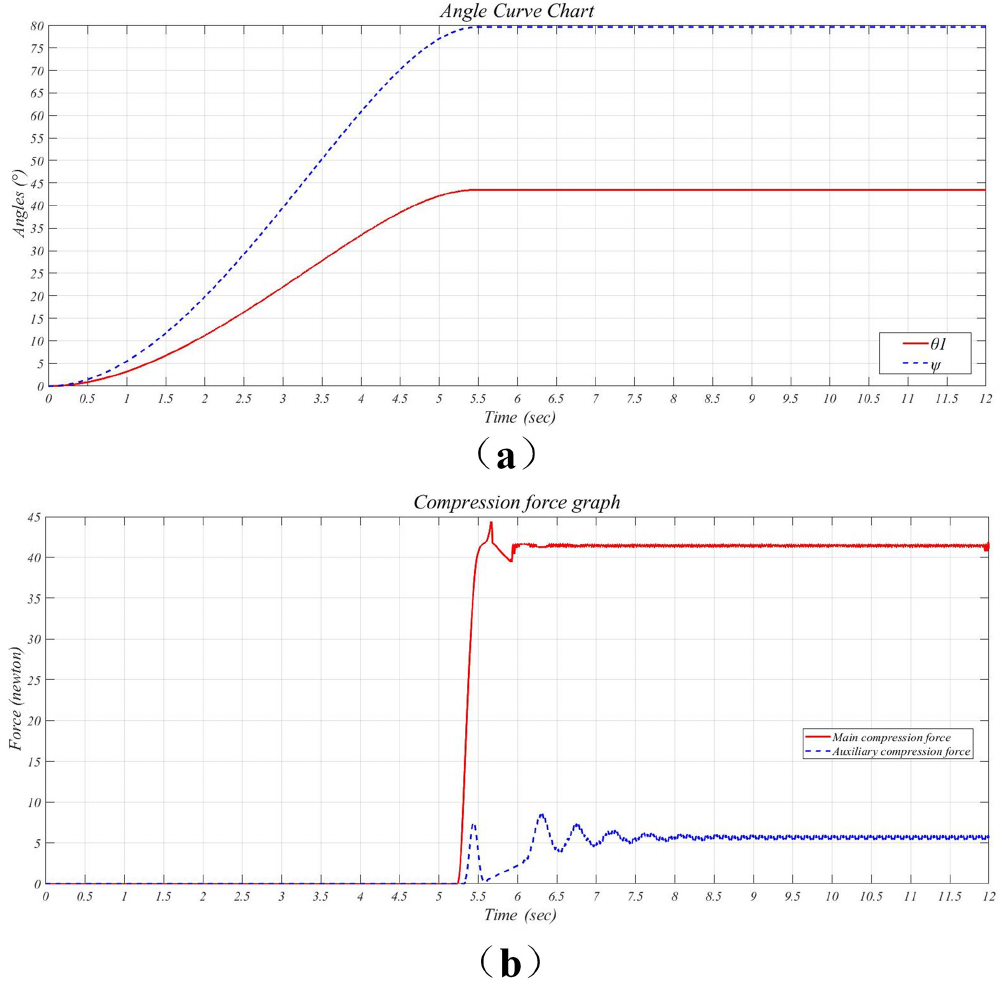
Figure 11. The simulation analysis of the pressing force. (a) Maximum angle of the θ 1 and the ϕ . (b) Maximum force of the main pressing force and auxiliary pressing